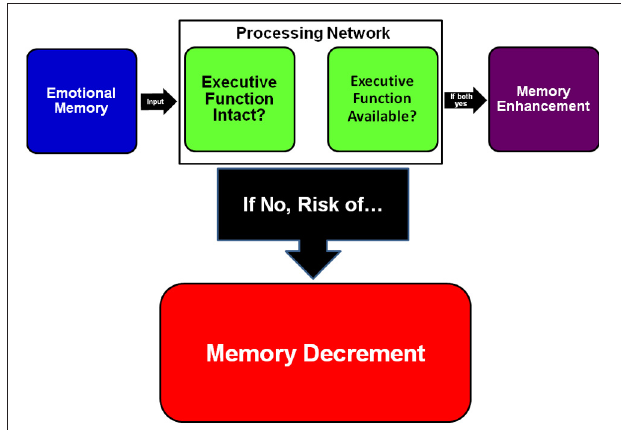
FIGURE 1 | A model based on Borg et al. (2011) and colleagues’ view of how occupied or impaired cognitive resources can change how emotion affects memory encoding. If individuals’ executive function resources are otherwise engaged or individuals’ executive function is impaired, as in Alzheimer dementia, the model predicts greater likelihood of emotional memory decrement. Patients with intermediate executive function impairment, as in MCI or early AD, would be hypothesized to have relatively normal emotional memory enhancement.